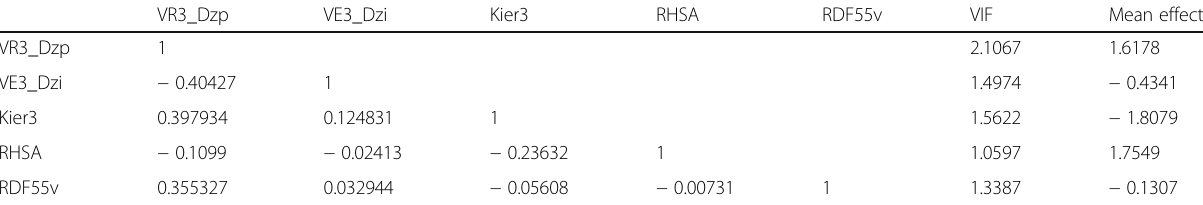
Table 3 Correlation, VIF, and mean effect of molecular descriptors